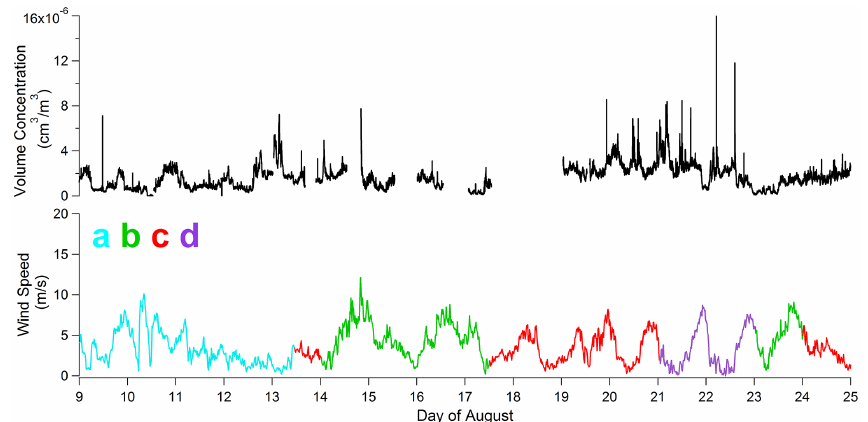
Figure 3. Time series (PDT) for 9–25 August of SMPS total volumetric concentrations (top) and wind speed (bottom). The wind’s direction is classified as type a, b, c and d, according to the air mass classification scheme described in Sect.